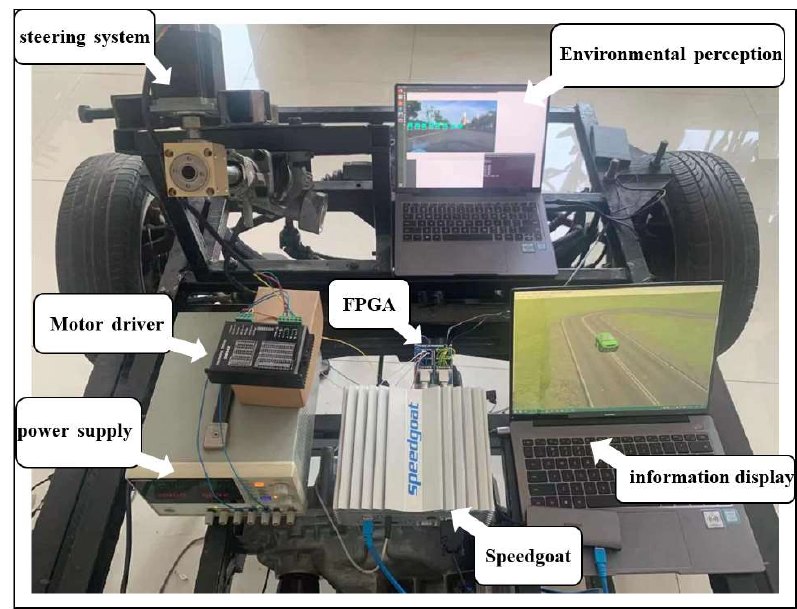
Figure 11. Hardware in the loop test platform.